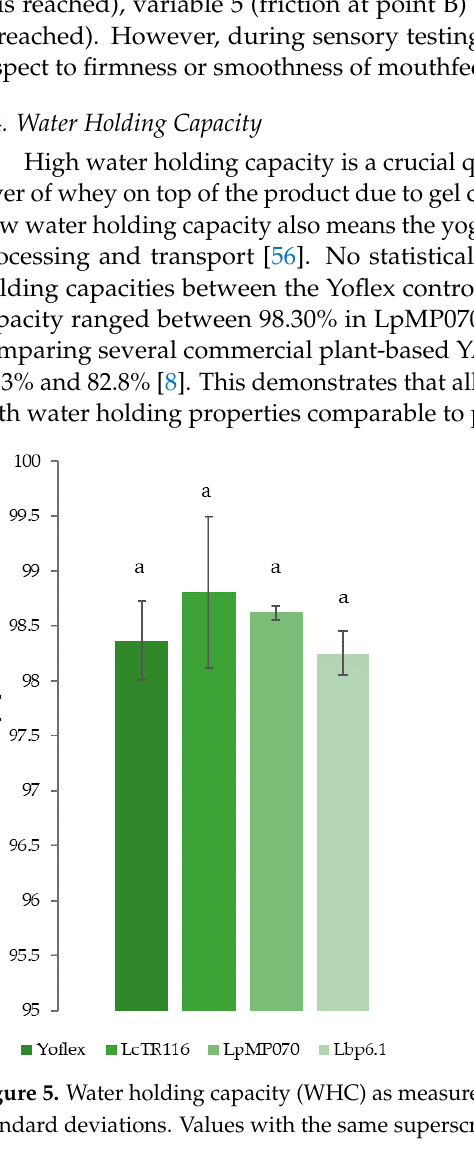
Table 4. Gel point in minutes of oscillatory analysis during fermentation; losses in storage modulus ( Δ G ′ ) and loss modulus ( Δ G ′′ ) in percent between the end of the first oscillatory interval and the end of the second oscillatory interval of the three-interval-thixotropy test; Variables 4–6 of tribological analysis.